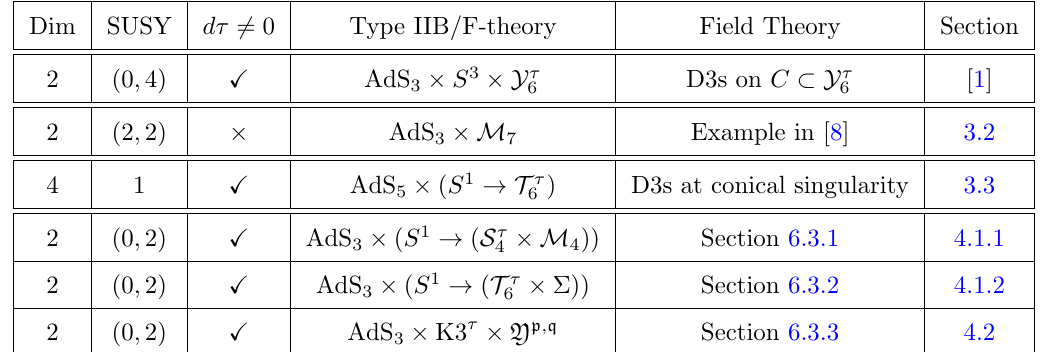
Table 1 . Summary of various AdS 3 and AdS 5 solutions in Type IIB/F-theory with (cid:12)ve-form (cid:13)ux, including supersymmetries, the geometry of the solution and the dual (cid:12)eld theory. The spaces with a superscript (cid:28) are elliptically (cid:12)bered, and only in the case of Y (cid:28) metrics. In general they are elliptic (cid:12)brations with non-trivial Ricci